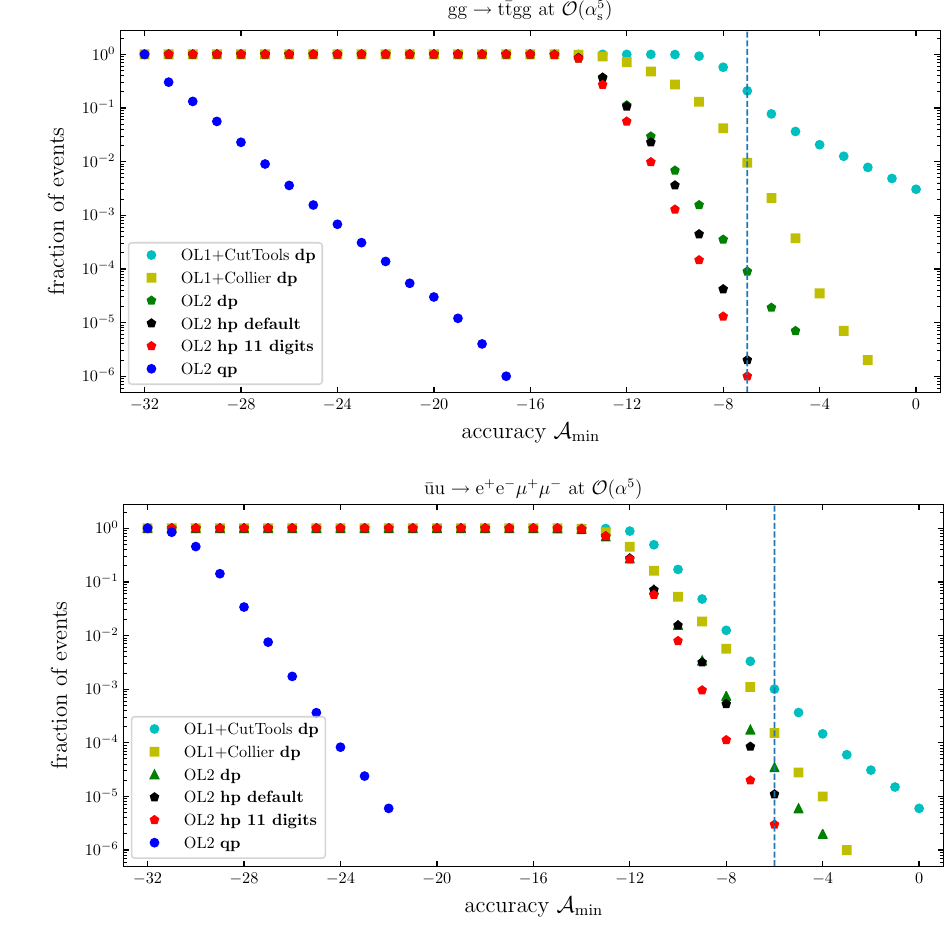
Fig. 5 Probability of finding an instability A > A min as a function of A min in a sample of 10 6 events for gg → t ¯ tgg at NLO QCD (upper plot) and ¯ uu → e + e − μ + μ − at NLO EW (lower plot). The stability of quad-precision benchmarks (blue) is compared to different variants of the OpenLoops 2 on-the-fly reduction (green, black, red) and to the OpenLoops 1 algorithm interfaced with